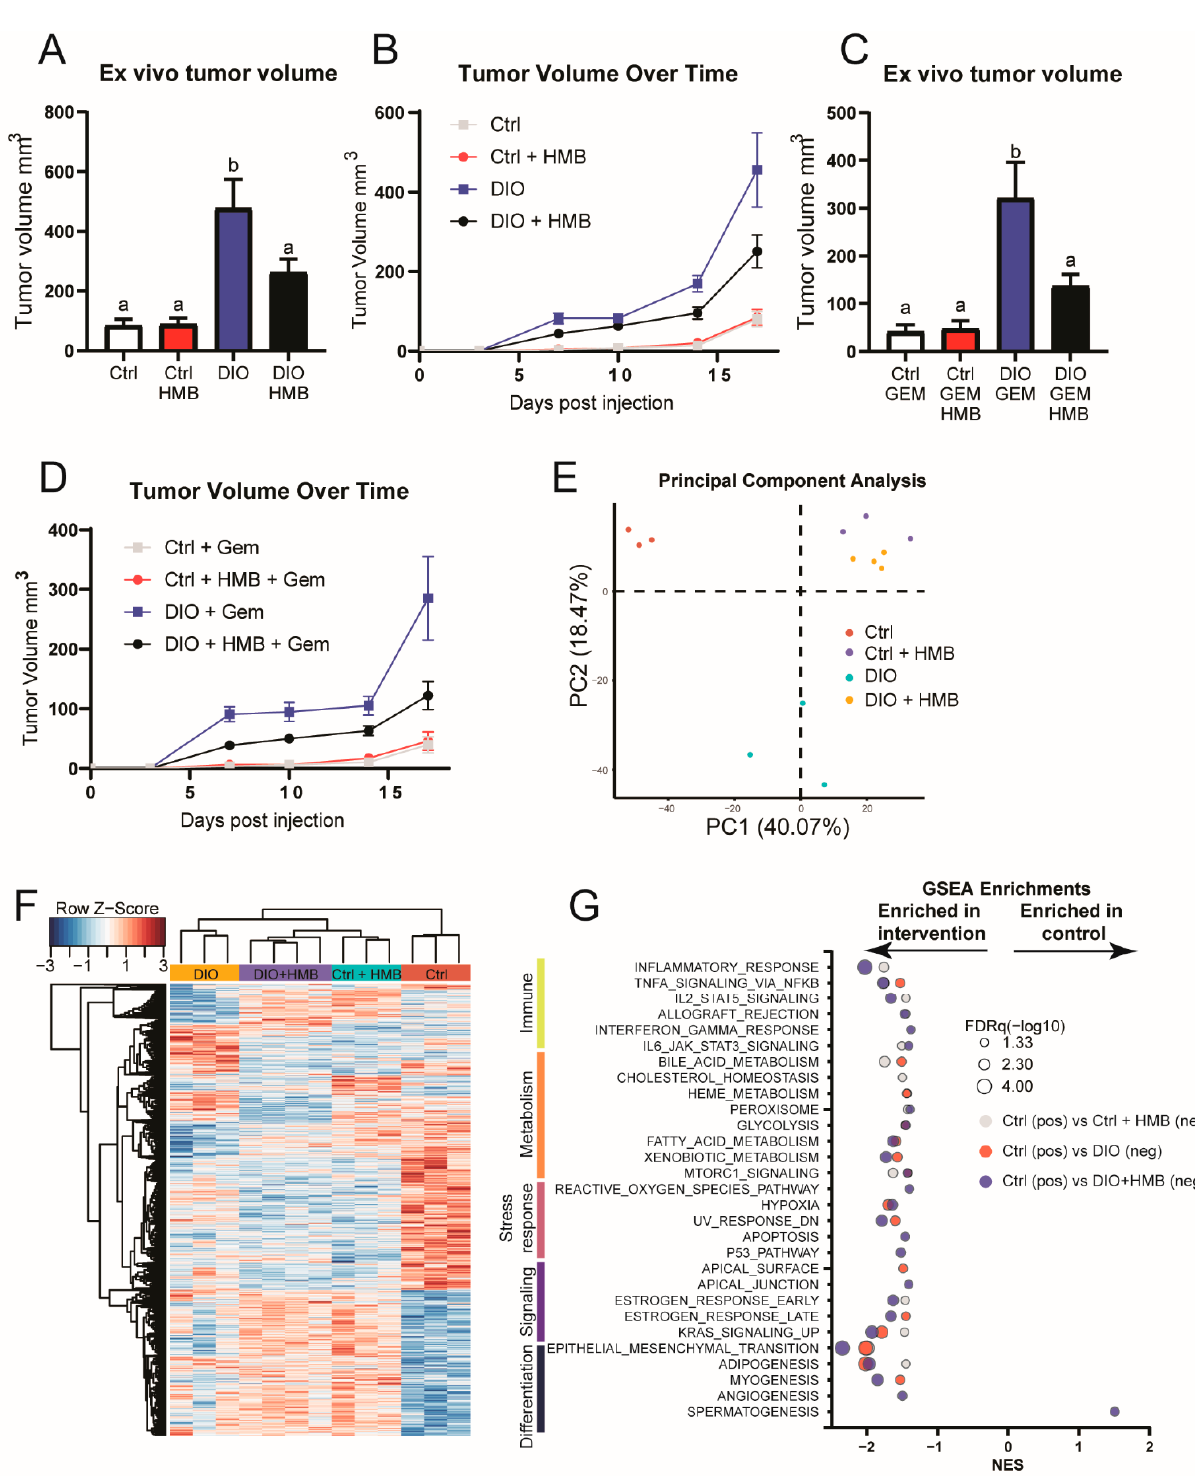
Figure 1. ( A , B ) Tumor volume in control and DIO mice with or without HMB supplementation at study termination ( A ) or over time ( B ) ( n = 14/group). ( C , D ) Gemcitabine-treated tumor volume in control and DIO mice with or without HMB supplementation at study termination ( C ) or over time ( D ) ( n = 13–15/group). ( E – G ) Transcriptomic analysis of tumors from control and DIO mice with or without HMB supplementation. ( E ) Principal component analysis ( n = 3–4/group) and ( F ) hierarchical clustering ( n = 3–4/group). ( G ) Significant GSEA enrichments from Hallmark gene sets resulting from comparing control vs. control + HMB (gray), control vs. DIO (red), and control vs. DIO + HMB (blue) mice. FDRq is denoted by the bubble size. All data are presented as means ± SEM. Differences are considered significant if p < 0.05, as indicated by different letters within the same graph.